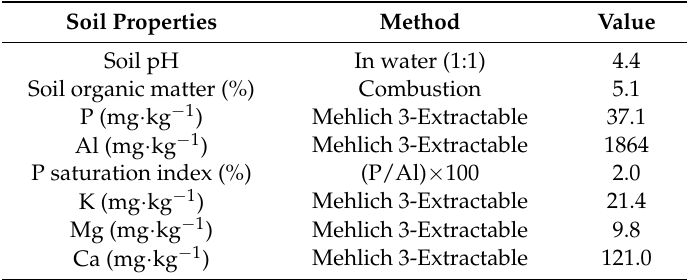
Table 1. Initial chemical properties of the mineral soil (Mistassini loamy sand) used for this study. Soil Properties Method Value Soil